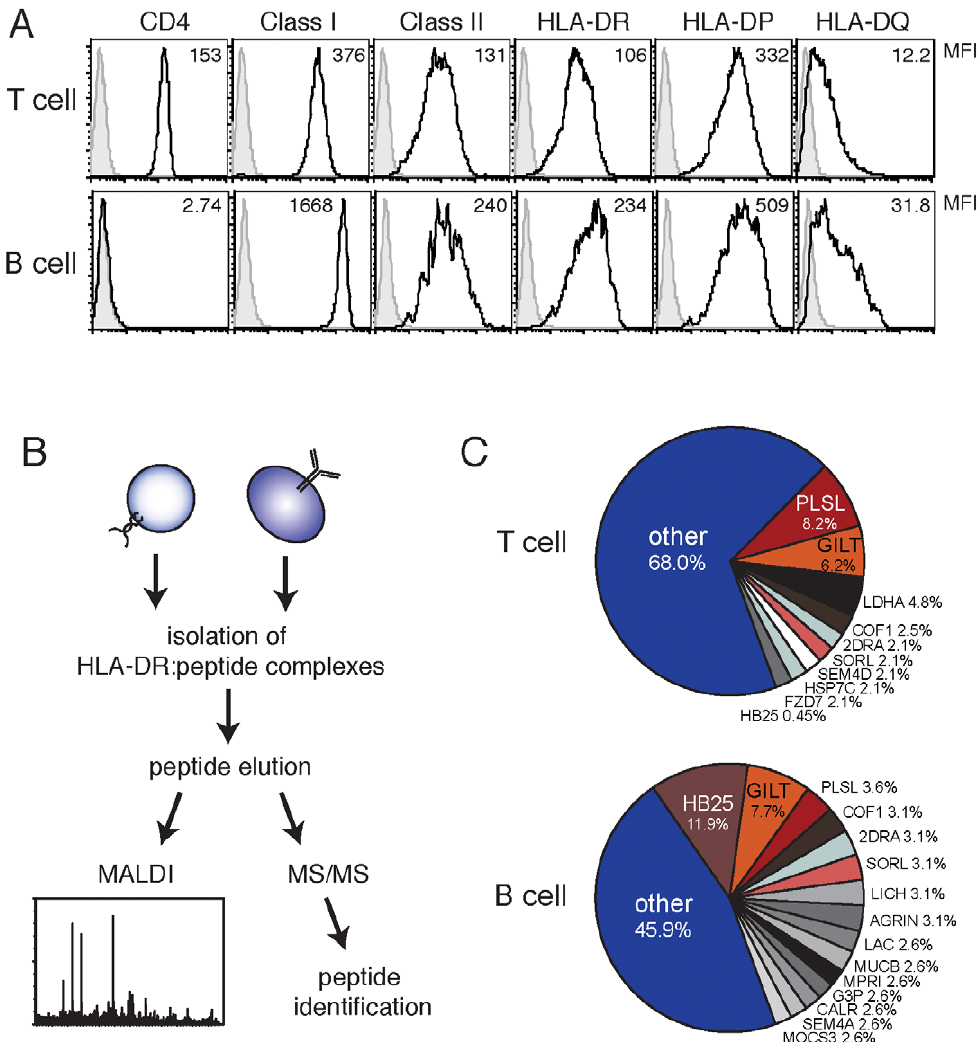
Figure 1. Isolation of HLA-DR:self-peptide complexes from an expanded class II MHC positive T cell clone (T cell) and a EBV- transformed B cell clone from the same donor. A . Characterization of class II MHC, class I MHC, and CD4 expression in a representative genetically-matched T cell clone and B cell line. B . Strategy used to identify self-peptides. HLA-DR:peptide complexes were immunoprecipitated from T and B cell lysates. Peptides were eluted from the MHC and assessed for quality and contaminants with MALDI before being subjected to multidimensional protein sequencing and identification using the SEQUEST algorithm. C . Frequency of common self-peptides identified T and B cells from a donor 1 (DRB1*1301; DRB1*1501 DRB3*0202;